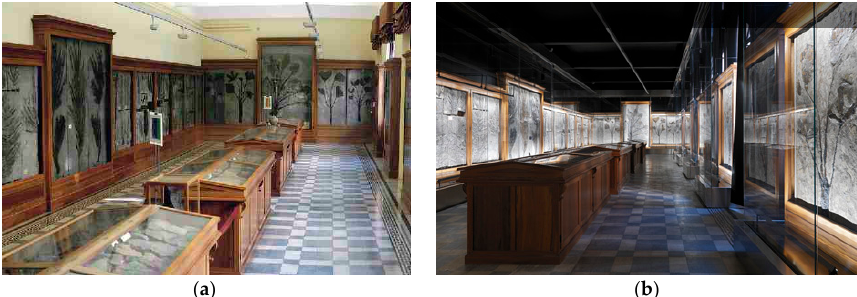
Figure 1. Internal view of the Hall of Palms ( a ) before and ( b ) after renovation.